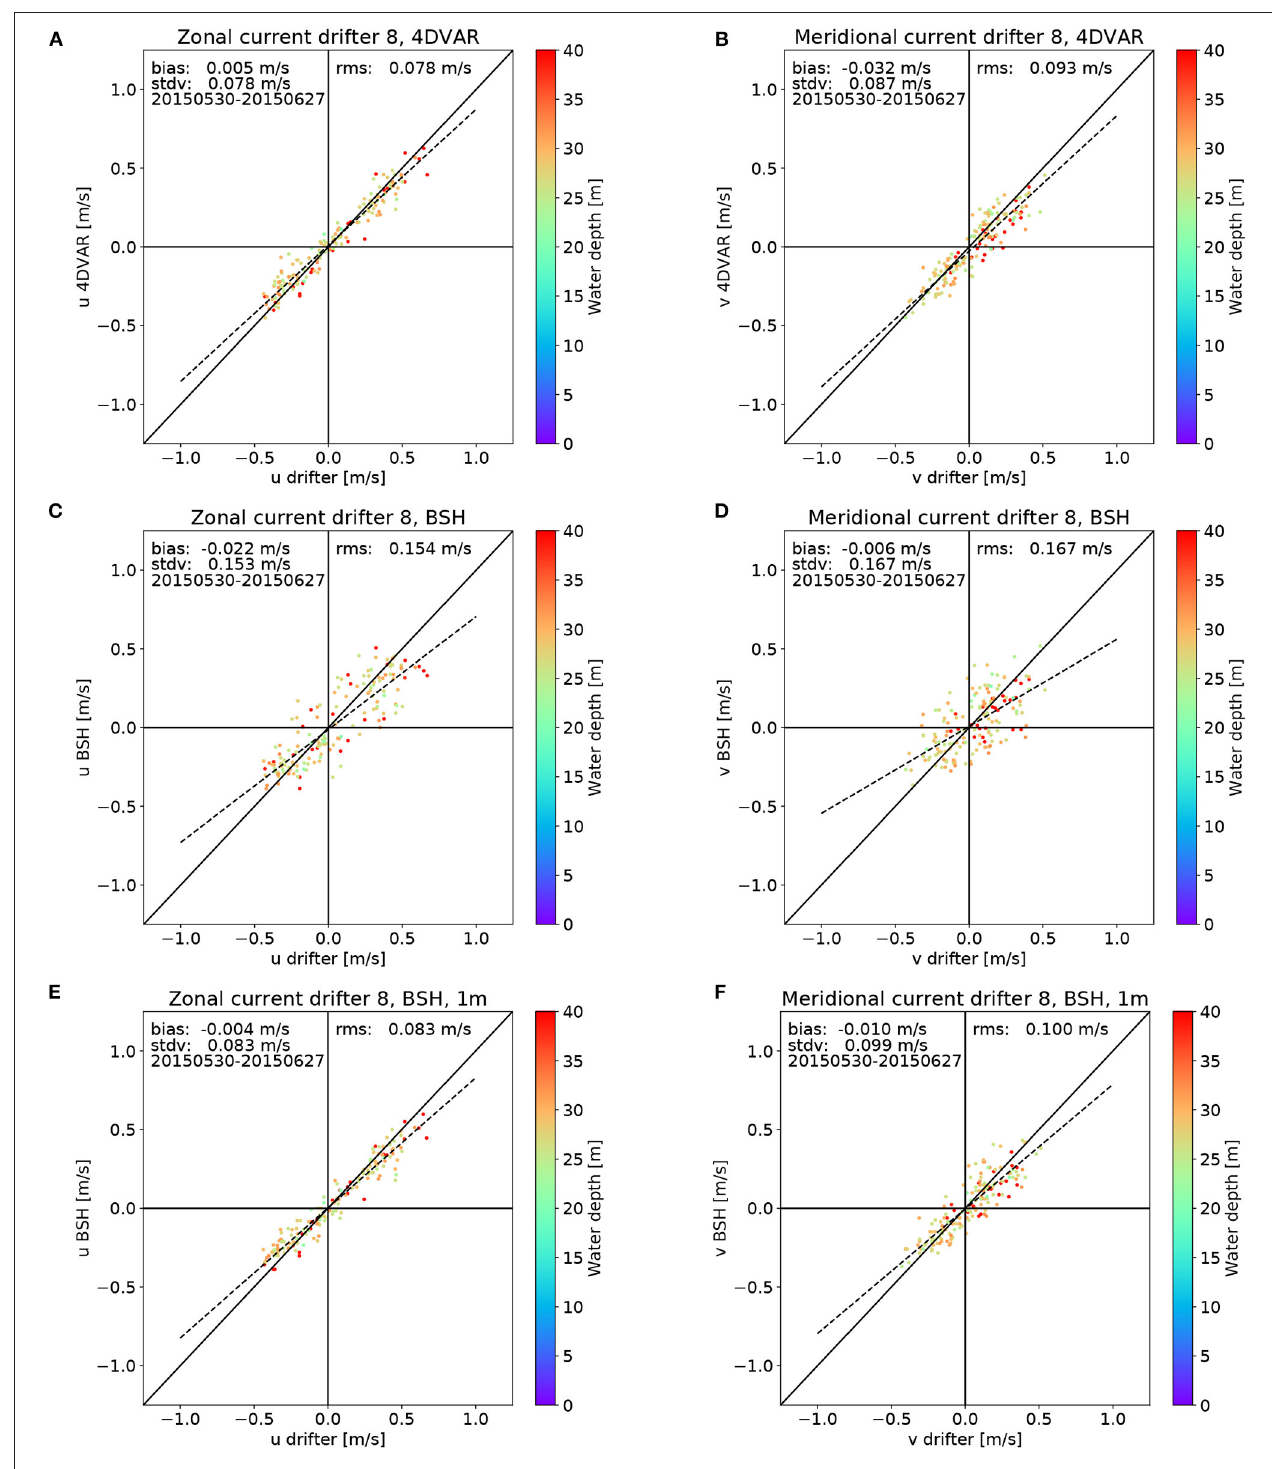
FIGURE 8 | Comparison of surface current speeds derived from drifter 8 (see Figure 2 ) with co-located estimates from the tuned IMCO model surface currents (A,B) , the BSH model surface currents (C,D) , and the BSH drift model (E,F) . Meridional components are shown on the left and zonal components on the right. The colour coding refers to water depth and dashed lines were obtained via linear